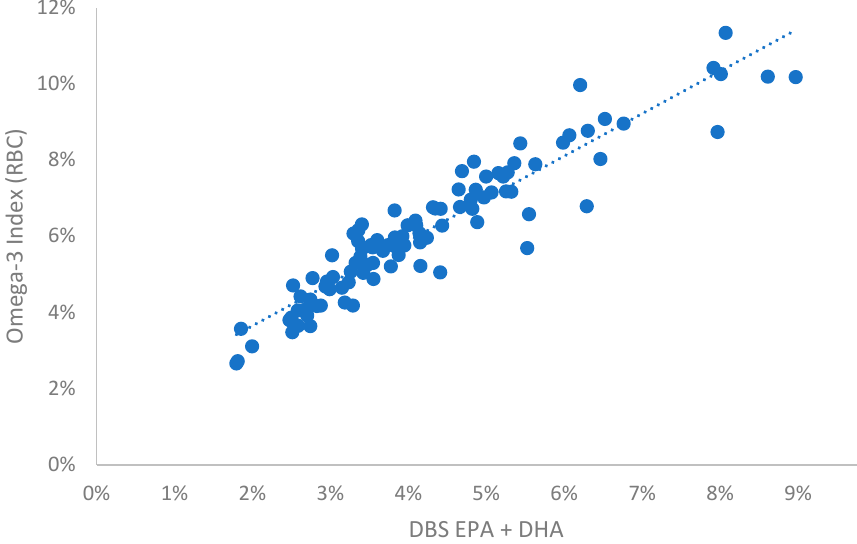
Figure 3. Relationship between the EPA + DHA content of DBS samples and the Omega-3 Index in 100 random human blood samples.